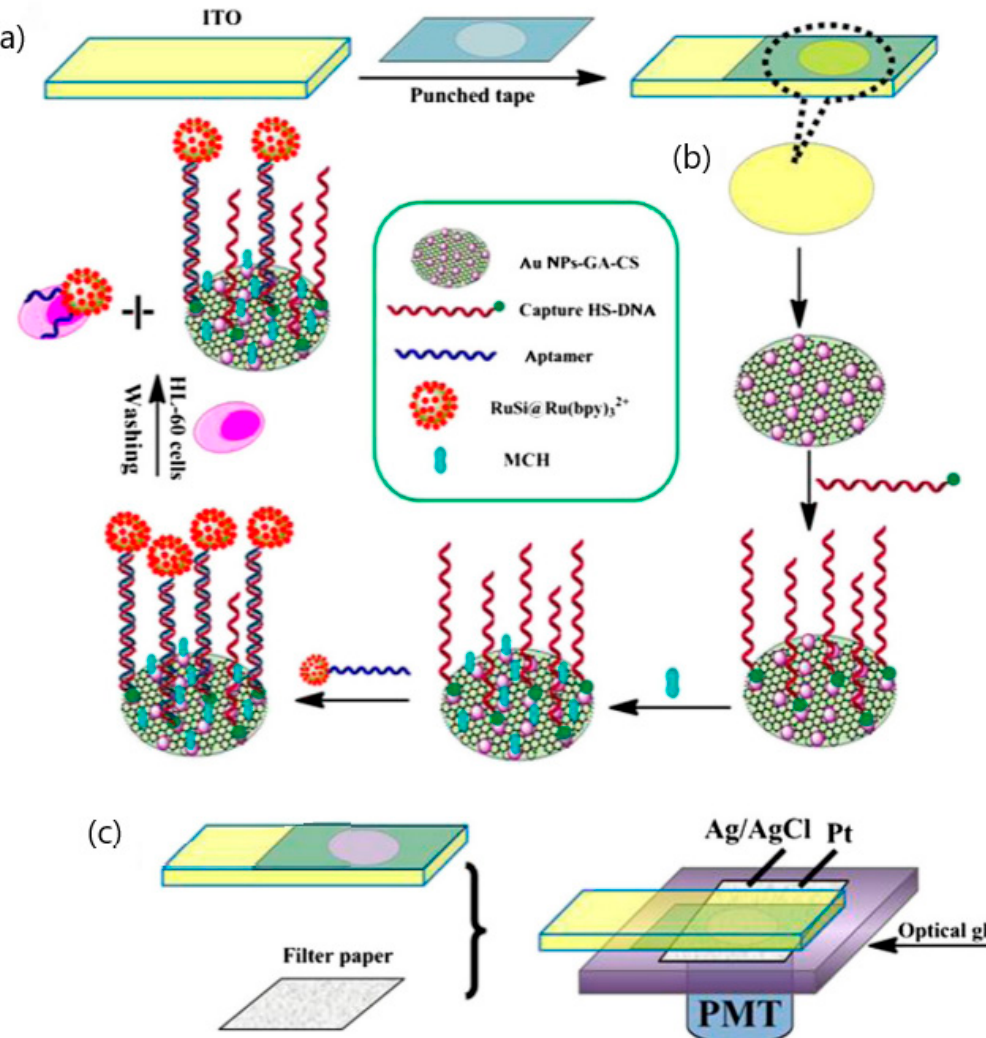
Figure 8. Schematic illustration of paper-based biosensor for Electrochemiluminescence (ECL) detection of human leukemia (HL-60) cells. (a) Fabrication of indium-tin oxide (ITO) electrode, (b) Sensing principle to HL-60 cancer cells based on [Ru(bpy) 3 ] 2+ -conjugated silica nanoparticles as emitter on the surface of ITO electrode, (c) A platinum wire and an Ag/AgCl wire were attached on to the filter paper with a clasp and used as the counter electrode and reference electrode, respectively [90].